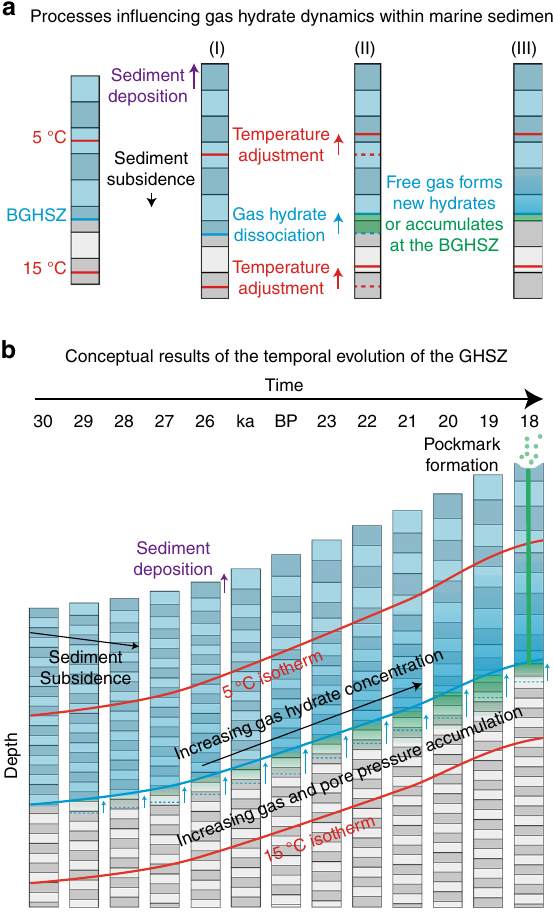
Fig. 3 Processes in fl uencing the gas hydrate dynamics within marine sediments. a Sediment gets deposited and the sedimentary column subsides (I), the temperature pro fi le and the base of the gas hydrate stability zone (BGHSZ) adjusts and gas hydrate dissociates (II). Free